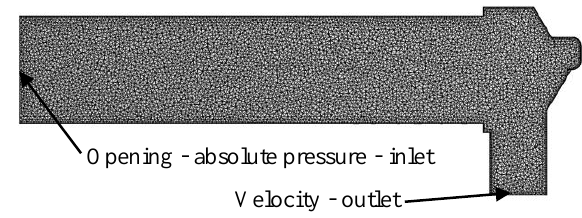
Fig. 5. The computational mesh and boundary conditions of the